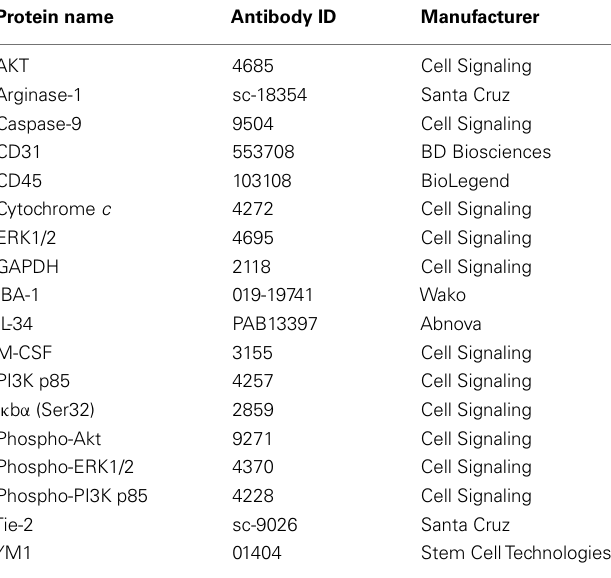
Table 1 |Antibodies included in the study